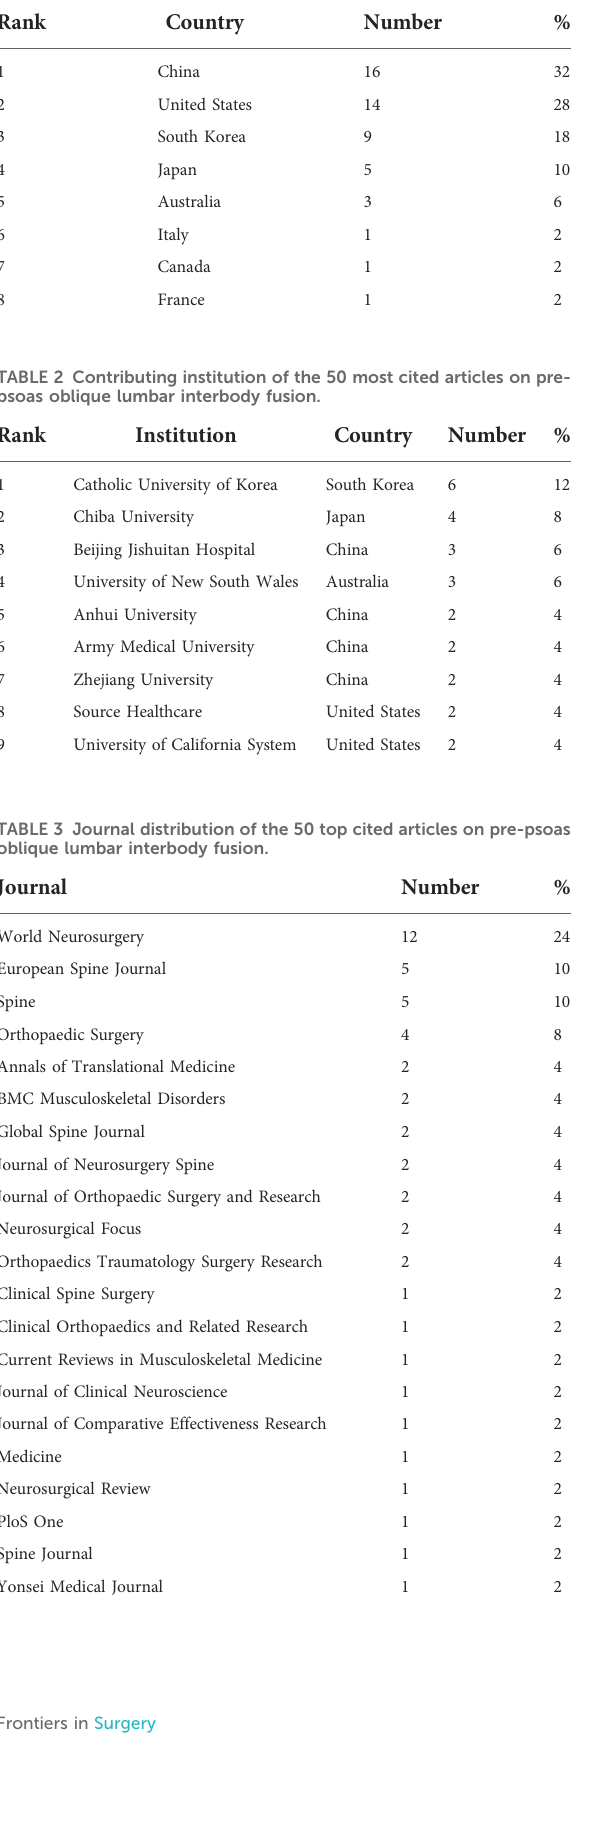
TABLE 4 Authors with multiple publications in the fi eld of pre-psoas oblique lumbar interbody